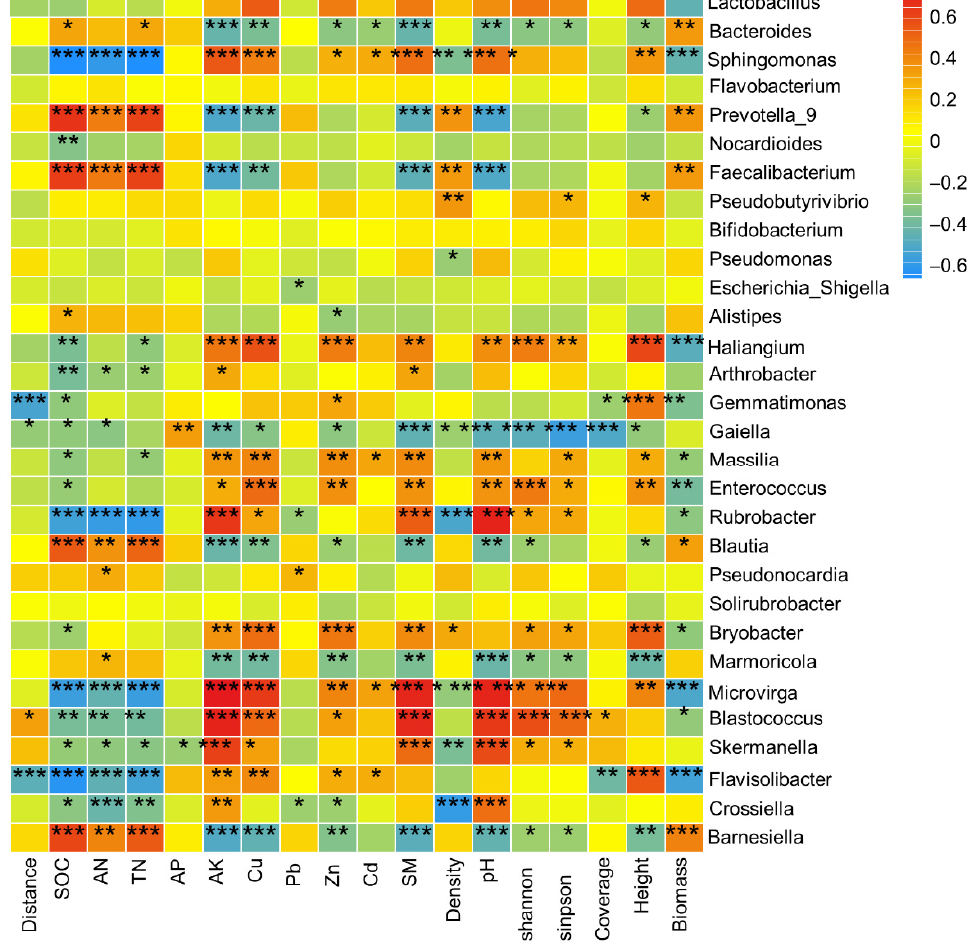
Figure 11. Pearson correlation heat map with correlation coefficient and significance levels based on the relative abundance of bacteria at the genus level and environmental factors. * Means p < 0.05 for significance test; ** means p < 0.01 for significance test; *** means p < 0.001 for significance test.